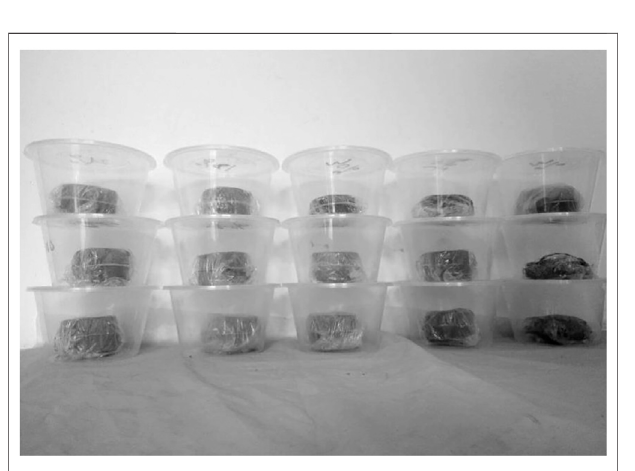
FIGURE 4 | Tailings specimens in the sealed jar.